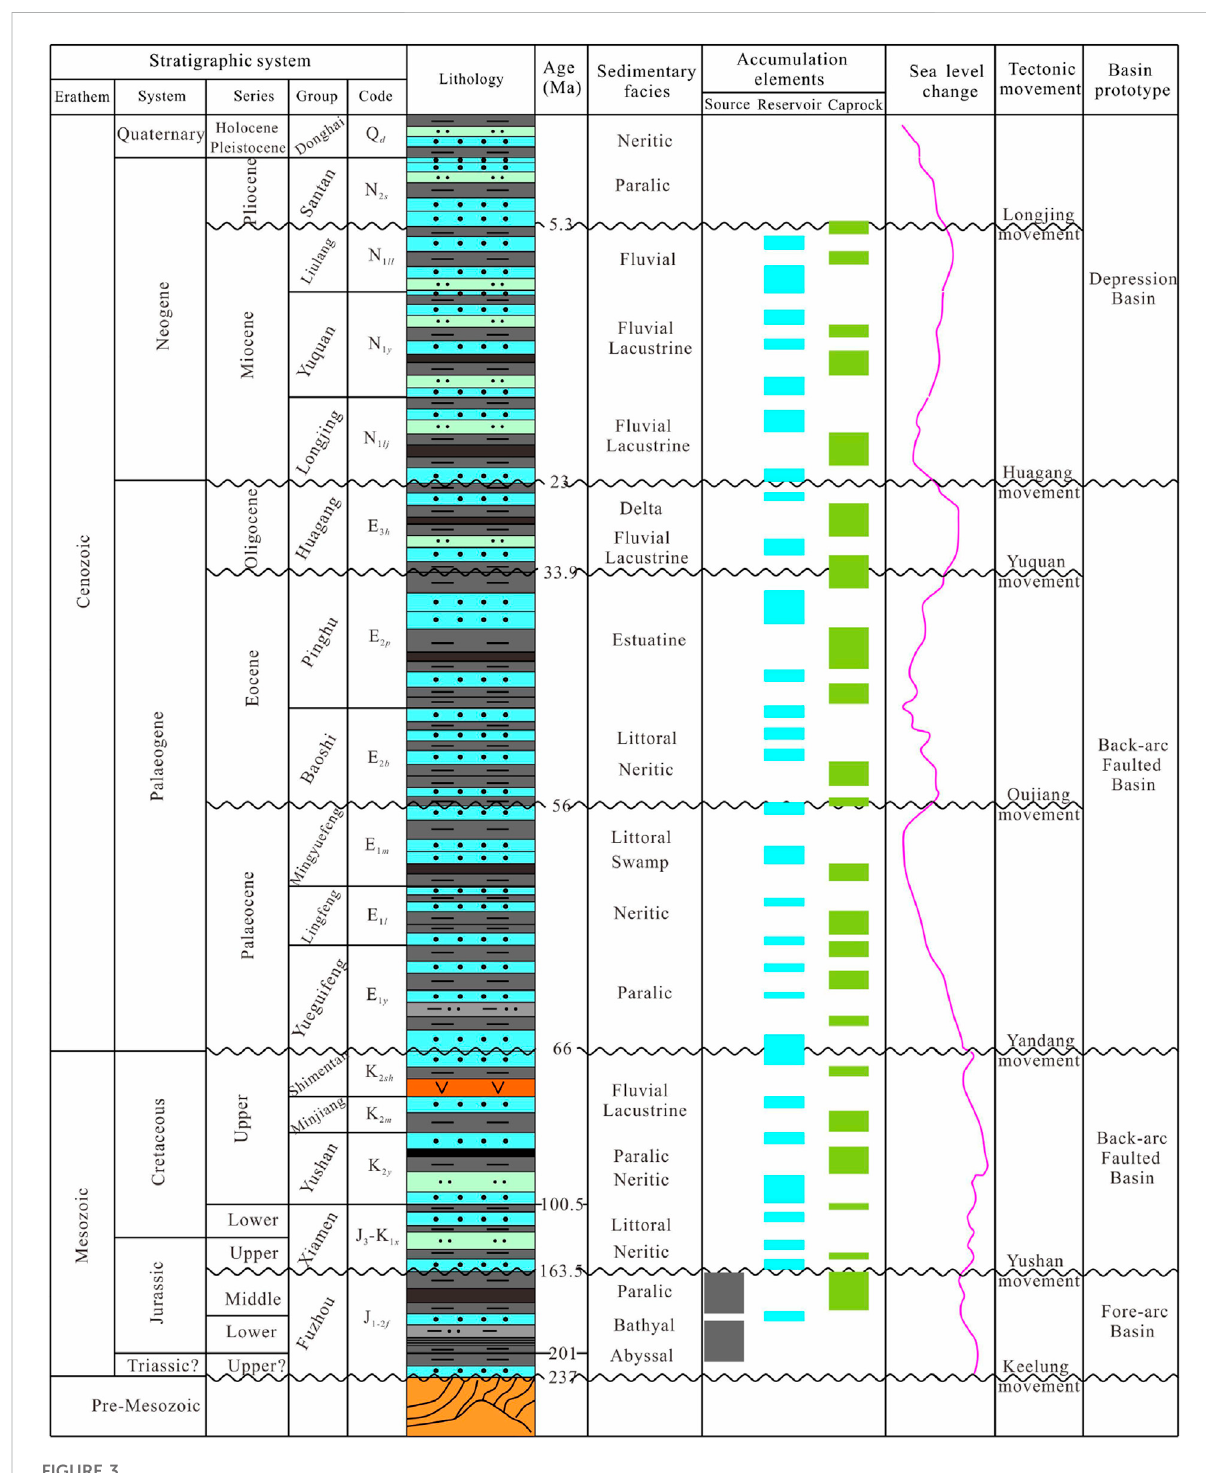
Stratigraphic chart of the SECS showing a combination of sedimentary facies, sea level changes, tectonic, and petroleum system since the Triassic (modi fi ed from Chen et al., 2016; Yang et al., 2012, 2017; Xiao et al., 2019; Wang et al., 2022a; as well as using drilling data of wells FZ10 and